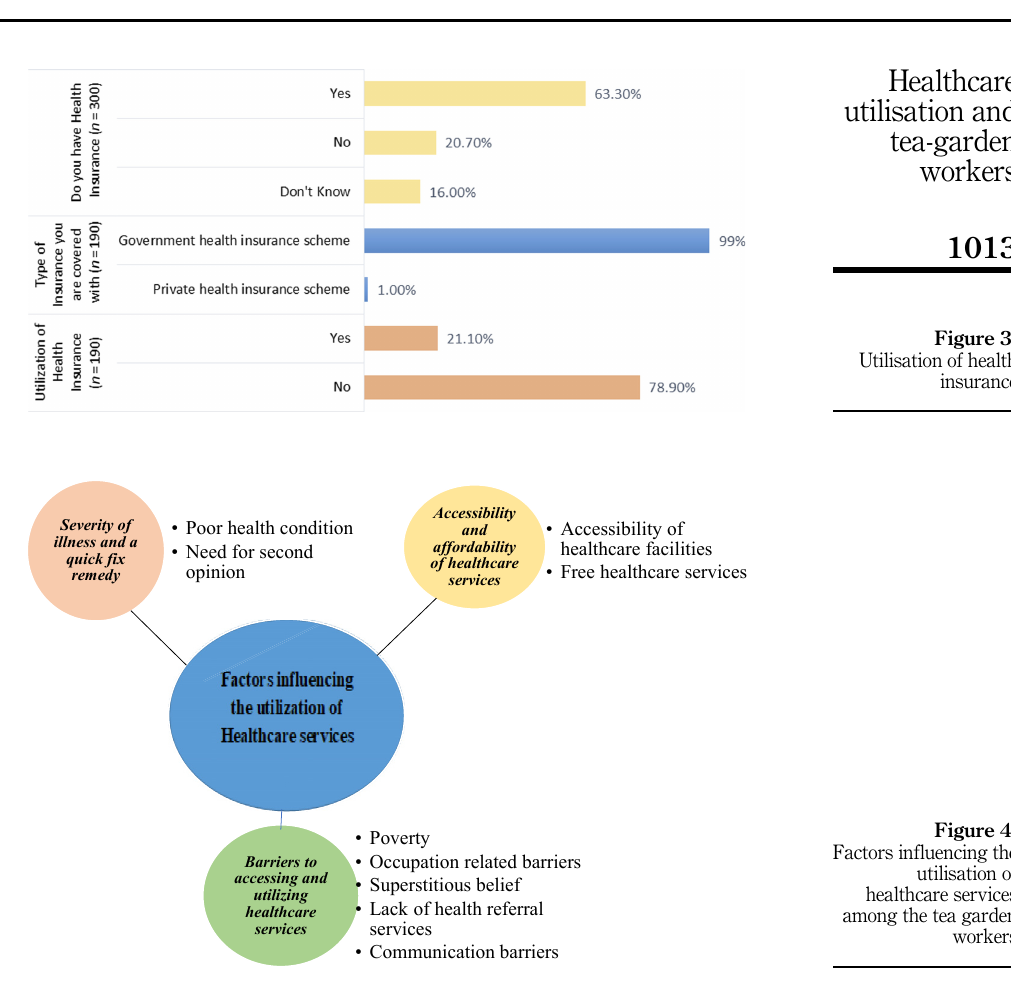
Figure 4. Factors influencing